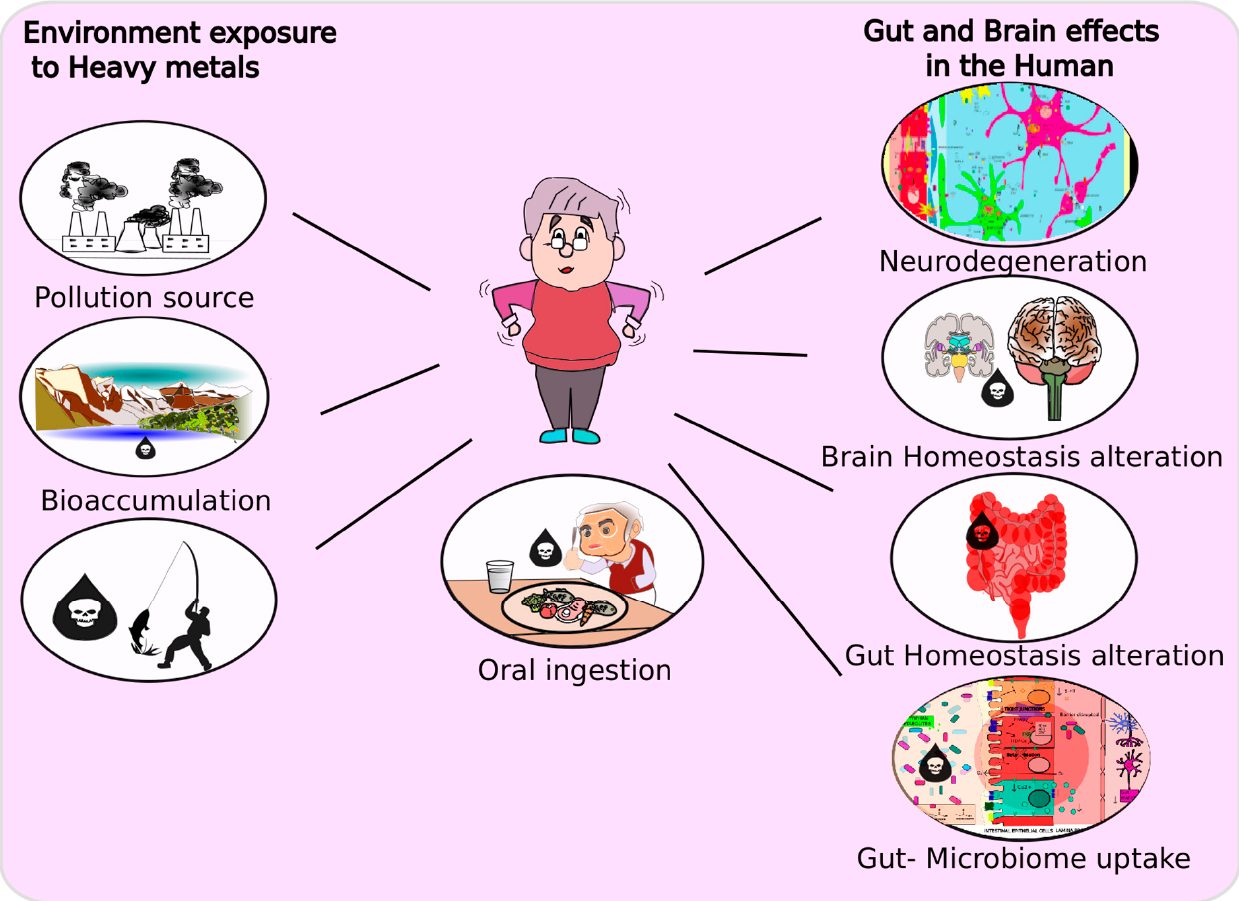
Figure 3. Human exposure to heavy metals in the diet underlies neurodegenerative diseases. Multiple levels of environmental exposure to heavy metals, which are derived from pollution, lead to adverse effects on the gut and brain in humans.